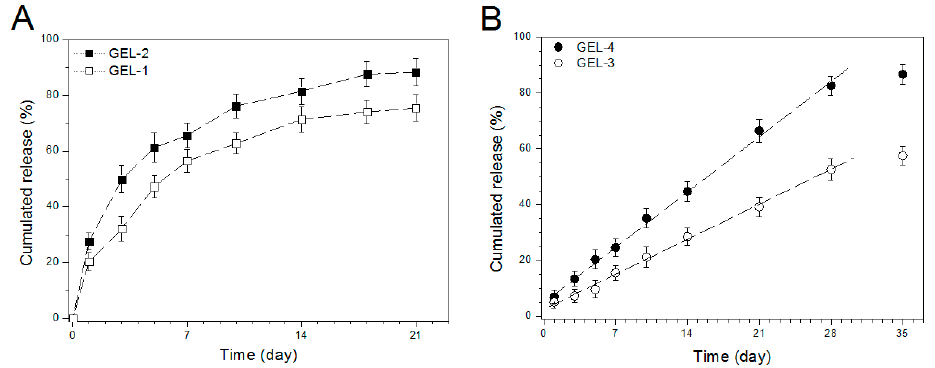
Figure 7. IGF-1 release patterns for gels directly loaded with IGF-1 ( A ) and for IGF-loaded BG/ALG– POL/SF gels ( B ).